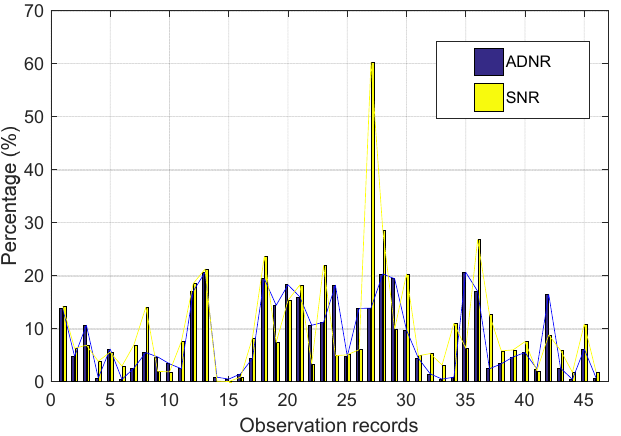
Figure 9. Percentage error fluctuation in the two algorithms. Blue and yellow represent the proposed algorithm (ADNR ) and SNR algorithm, respectively.